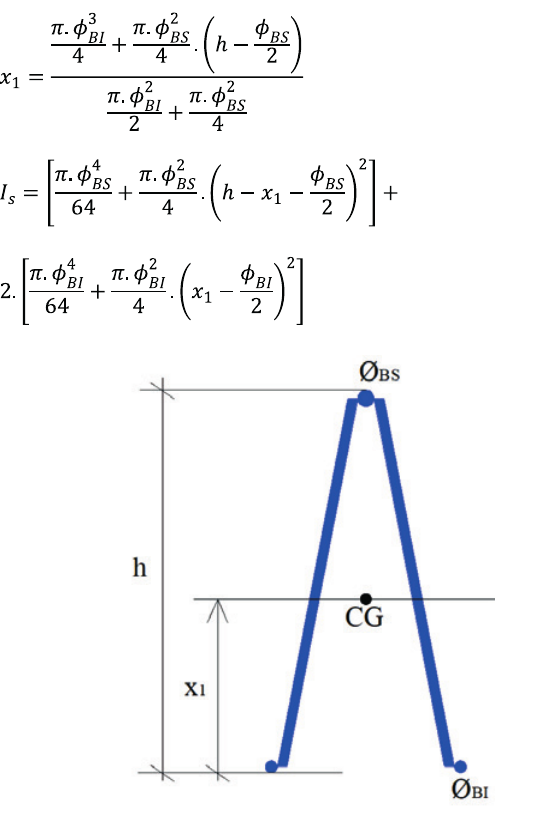
Center of gravity position for the lattice truss steel